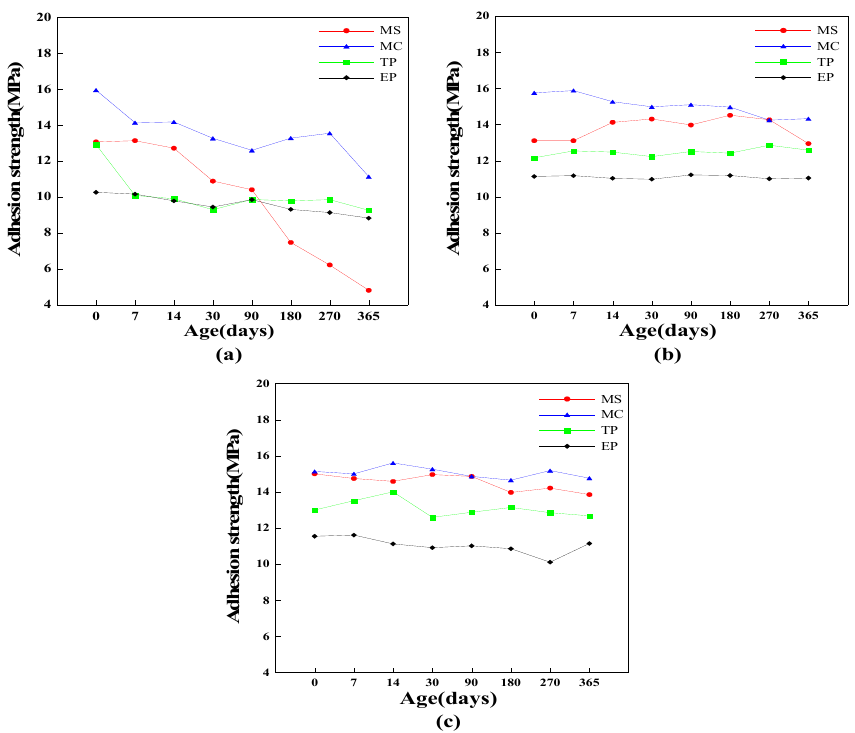
Figure 1. Adhesion strength of coating systems exposed to ( a ) tidal zone, ( b ) atmosphere zone, ( c ) underwater zone.